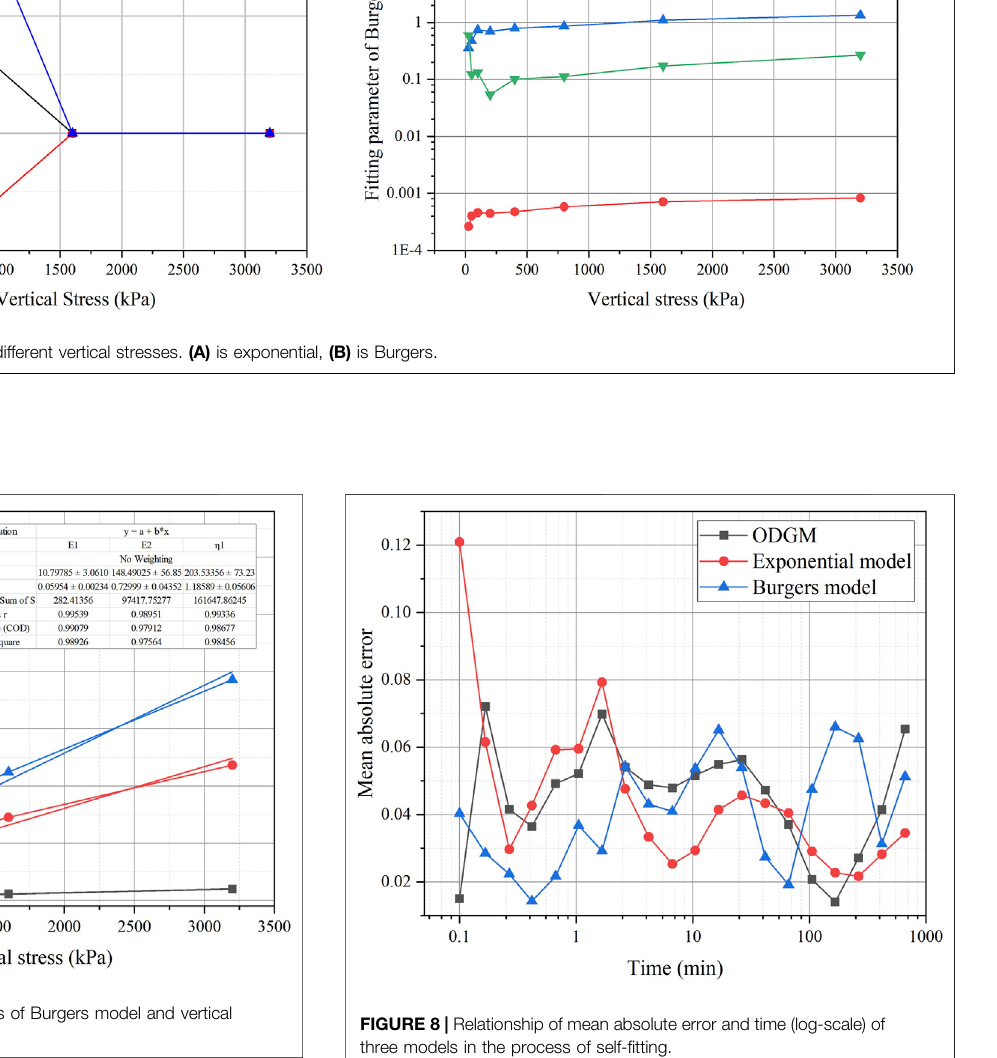
Frontiers in Physics |